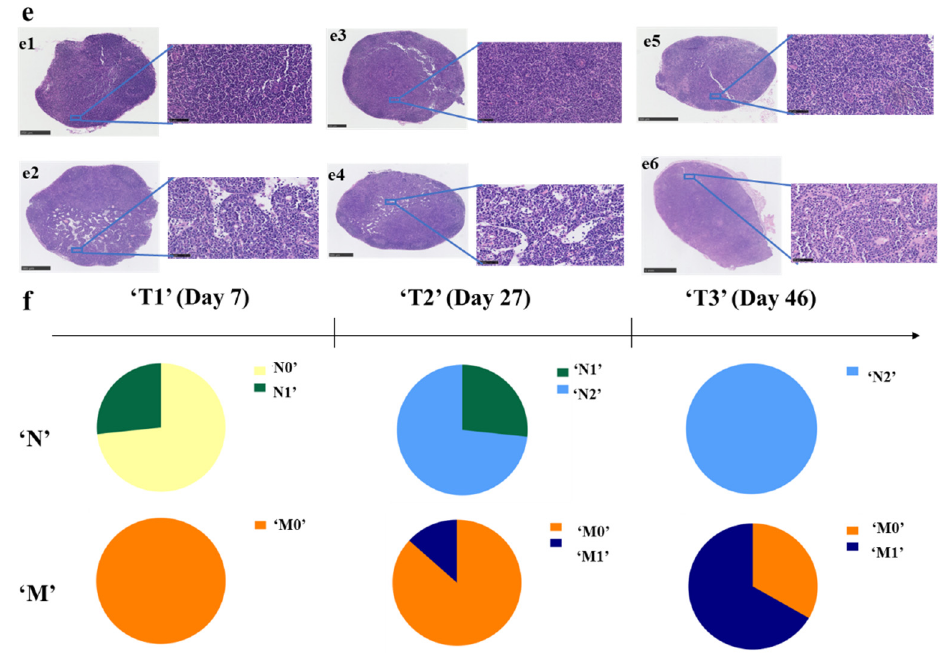
Figure 2. Division of ‘TNM’ stage at the animal level. ( a ) Three-dimensional reconstructions of ultrasound imaging data for tumors that were evaluated in the study. The segmented volume is shown in blue. ( b ) Tumor logistic growth curve with high fitting degree (R 2 = 0.978, n = 6). ( c ) Immunohistochemistry with anti-Ki-67 antibody in tumor tissues of ‘T1’ ( n = 15), ‘T2’ ( n = 15) and ‘T3’ ( n = 15) stages BC mouse model. The average optical density (AOD) in the ‘T2’ stage was significantly higher than that in the ‘T1’ and ‘T3’ stages, (* p < 0.05, *** p < 0.001) ( d ) Typical H&E staining of lung tissues. Non-metastatic lung tissue ( d1 ) and metastatic lung tissue ( d2 ). ( e ) Typical H&E staining of lymph nodes. Non-metastatic popliteal lymph nodes ( e1 ), metastatic popliteal lymph nodes ( e2 ), non-metastatic contralateral inguinal lymph node ( e3 ), metastatic contralateral inguinal lymph node ( e4 ), non-metastatic axillary lymph nodes ( e5 ), and metastatic axillary lymph nodes ( e6 ). ( f ) ‘TNM’ stages of BC mouse model.